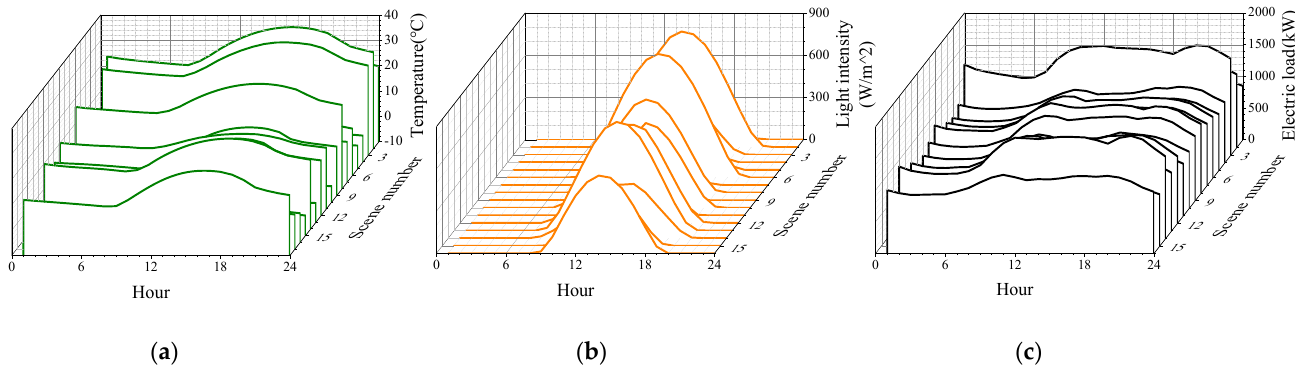
Figure 3. ( a ) Separate clustering results of temperature data; ( b ) Separate clustering results of light intensity data; ( c ) Separate clustering results of load data.